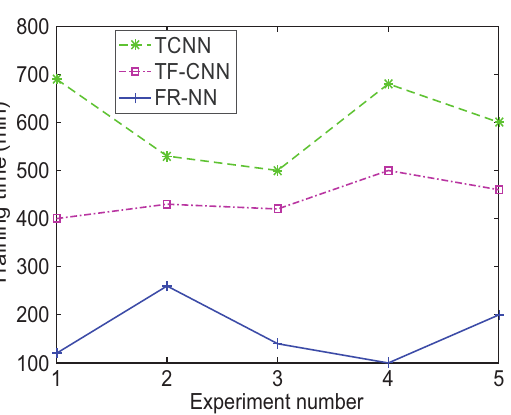
Fig. 5 Accuracy for different algorithms.